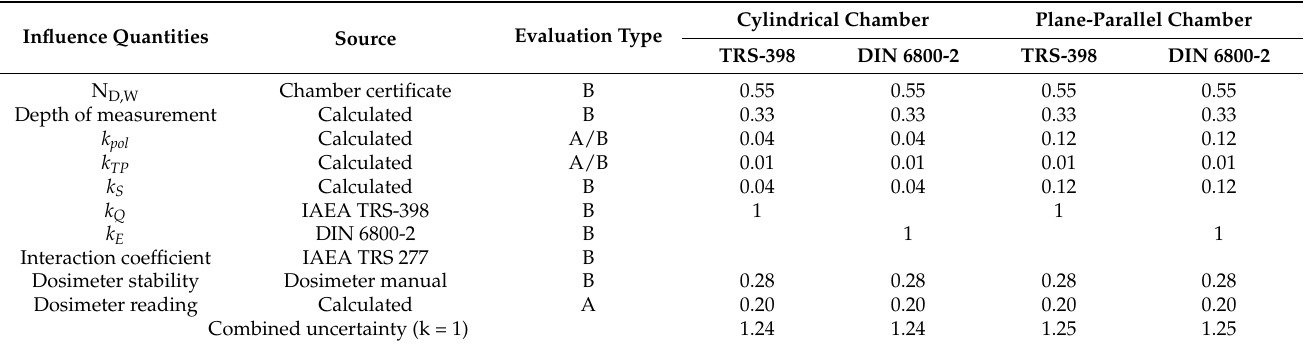
Table 6. Relative uncertainty (%) associated with absorbed dose to water, N D,W , measurements using the IAEA TRS-398 and DIN 6800-2 dosimetry